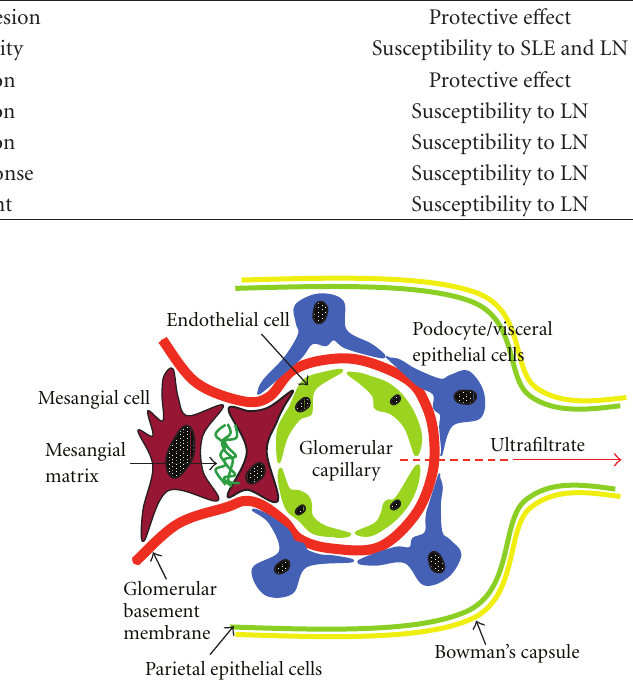
Figure 1: Schematic representation of the di ff erent cell types of the glomerular filtration